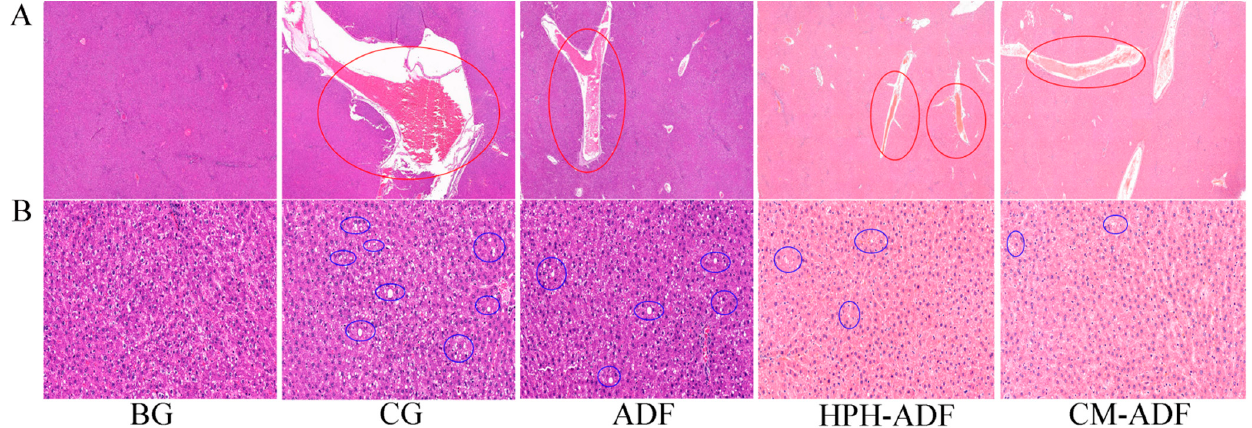
Figure 5. Hematoxylin-eosin-stained section of rat liver. ( A ) 2 × magnification; ( B ) 20 × magnification. From left to right: blank group (BG) with normal appearance, control group (CG), ADF group, HPH-ADF group and CM-ADF group. Hepatic congestion in red circles indicate hepatocyte damage, and round vacuoles in blue circles indicate hepatocyte steatosis.